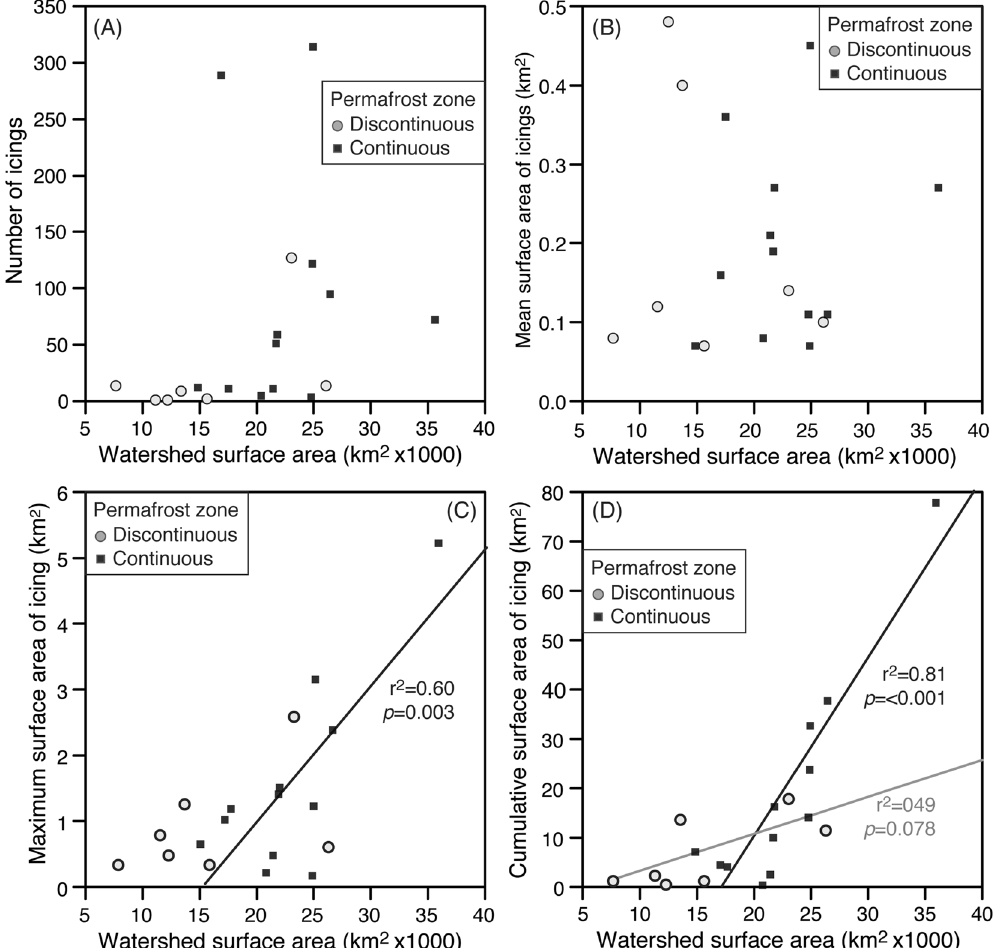
Figure 3. Number and extent of icings within their watersheds. Scatter plots of watershed surface area relative to ( A ) number of icings in the watershed; ( B ) mean surface area of icings in the watershed; ( C ) maximum surface area of icing in the watershed; ( D ) cumulative surface area of icings in the watershed. Linear trend lines are shown for statistically significant relations ( P <